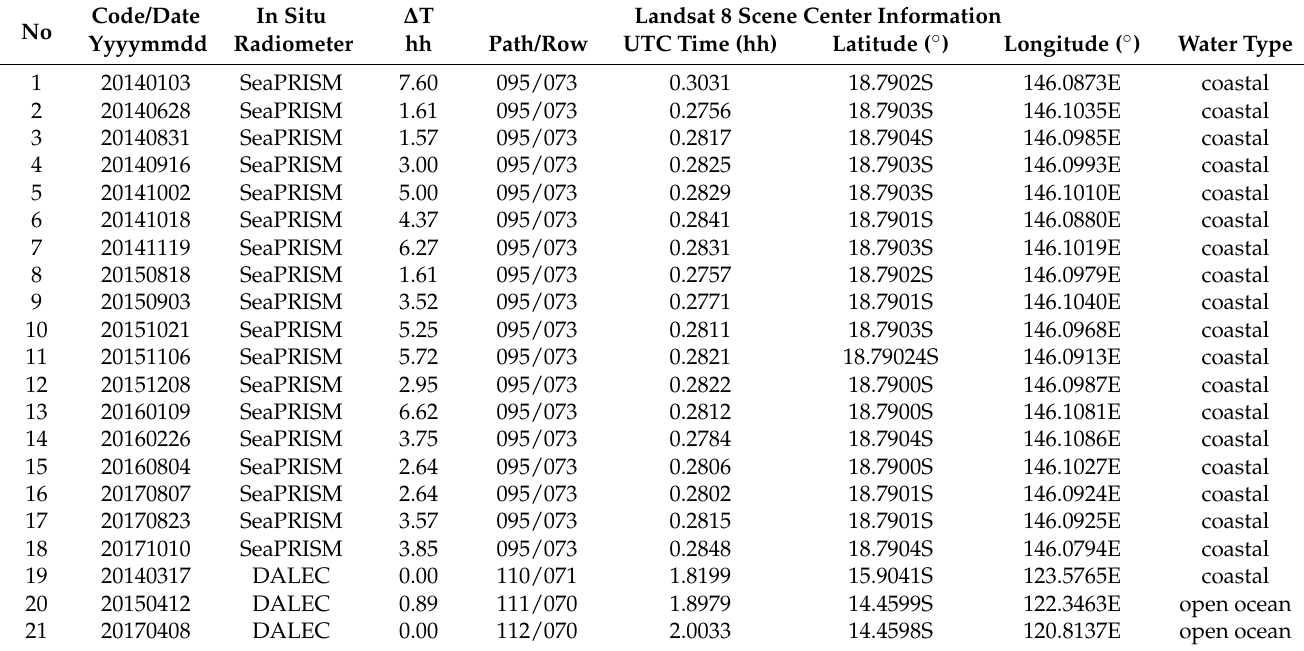
Table 1. Landsat 8 images used for